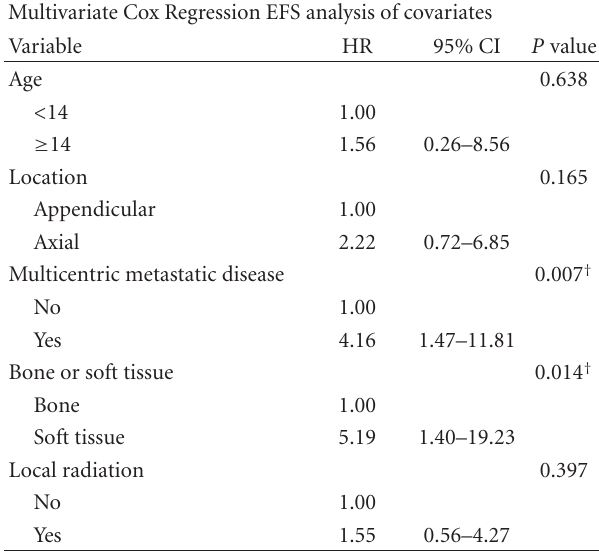
Table 7: Determination of independent variables for Event Free Survival (EFS) with multivariate Cox regression